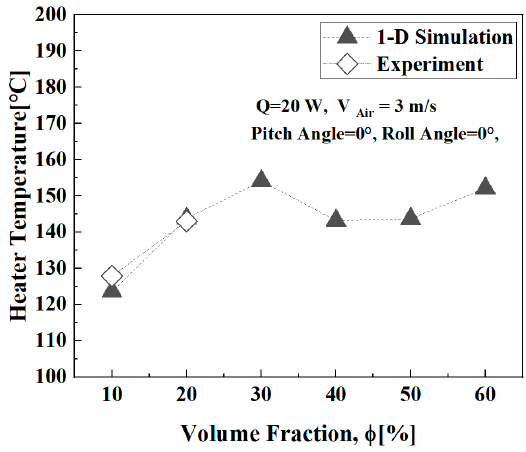
Figure 12. Simulated heater temperature according to the volume fraction of the CAHP ( V air = 3 m/s, Q = 20 W, pitch angle = 0°, and roll angle = 0°).